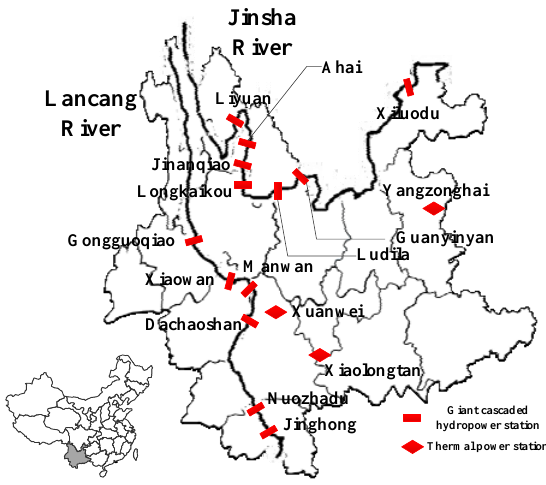
Figure 6. Locations of the giant cascaded hydropower stations and the thermal power stations in Yunnan. Table 1. The main attributes of the stations as power suppliers.